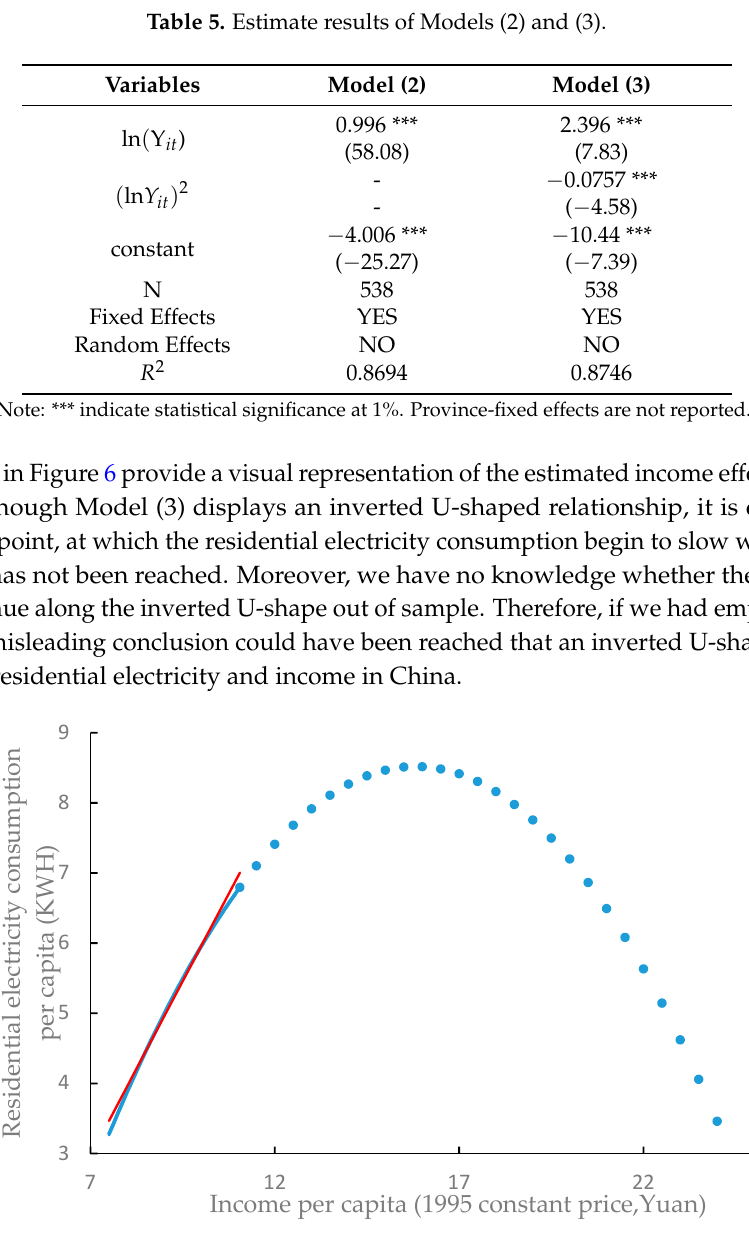
Figure 6. Estimated income effects of Models (2) and (3). Note: The residential electricity consumption per capita on the vertical axis has been adjusted for the effect of income, excluding the province-fixed effect. The red solid line captures the estimated income effects of Model (2) in the sample. The blue solid line and dotted line capture the estimated income effects of Model (3) in the sample and out of the sample, respectively.